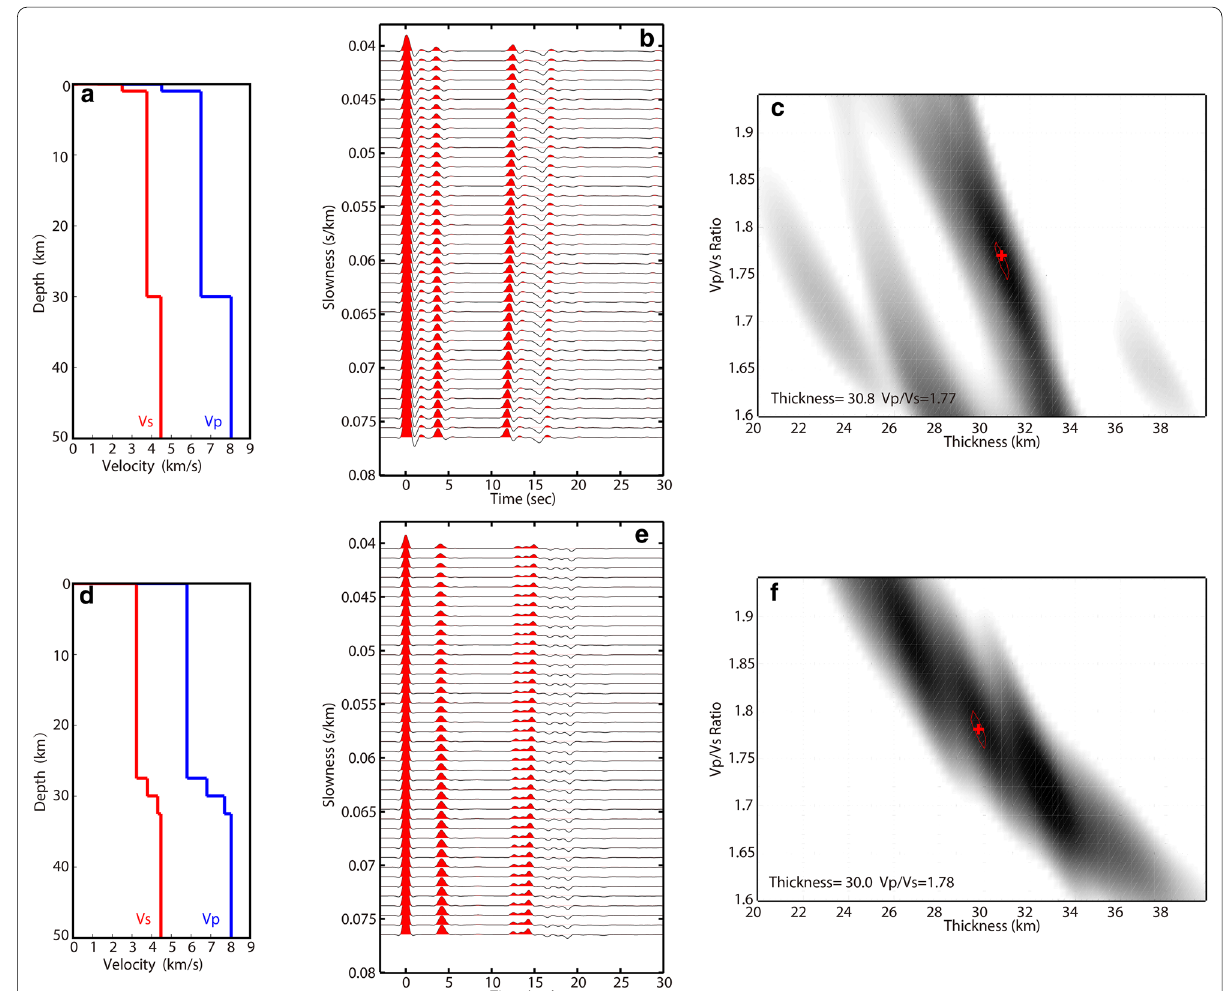
Fig. 8 Synthetic receiver function test. a The crustal velocity model with a 1-km-thick sedimentary layer. b Synthetic receiver function from model in a . c H -κ stacking of RF in b . d The crustal velocity model with a "transitional Moho". e Synthetic receiver function from model in d . f H -κ stacking of RF in